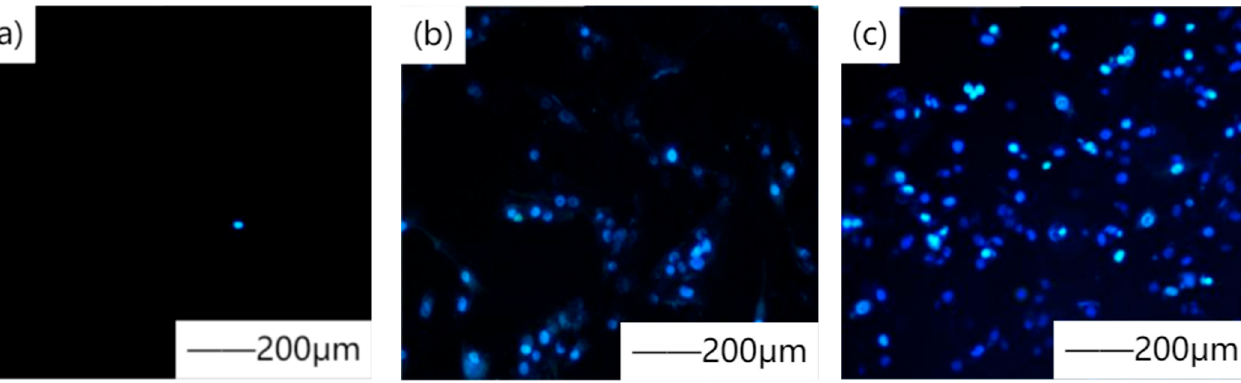
Figure 6. DAPI staining of nuclei of live osteoblast cells showing blue fluorescence on ( a ) uncoated and ( b ) Nb 2 O 5 coated substrates after incubation with MG63 osteoblast cells for 24 h and ( c ) nuclei of live cells observed on Nb 2 O 5 coated substrate after 48 h of incubation with MG63 osteoblast cells. (Ethidium bromide/acridine orange combined stain causes live cells to fluoresce green, whereas apoptotic cells cause the distinctive red-orange fluorescence.) Reprinted with permission from Ref. [55]. Copyright 2014 Copyright Elsevier.